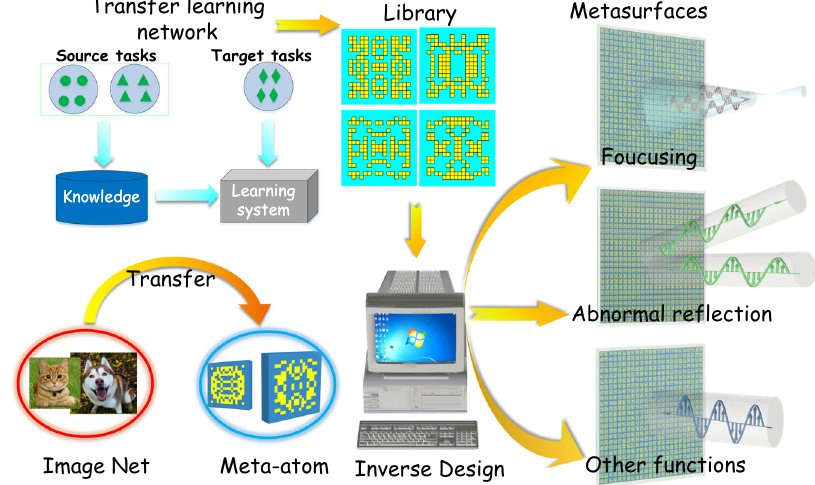
Fig. 1 A sketch of metasurface design via transfer learning. The knowledge of image classi fi cation is transferred to meta-atom design through the transfer learning architecture. Based on TLN, the full-phase-span library of meta-atoms is established and then applied for functional